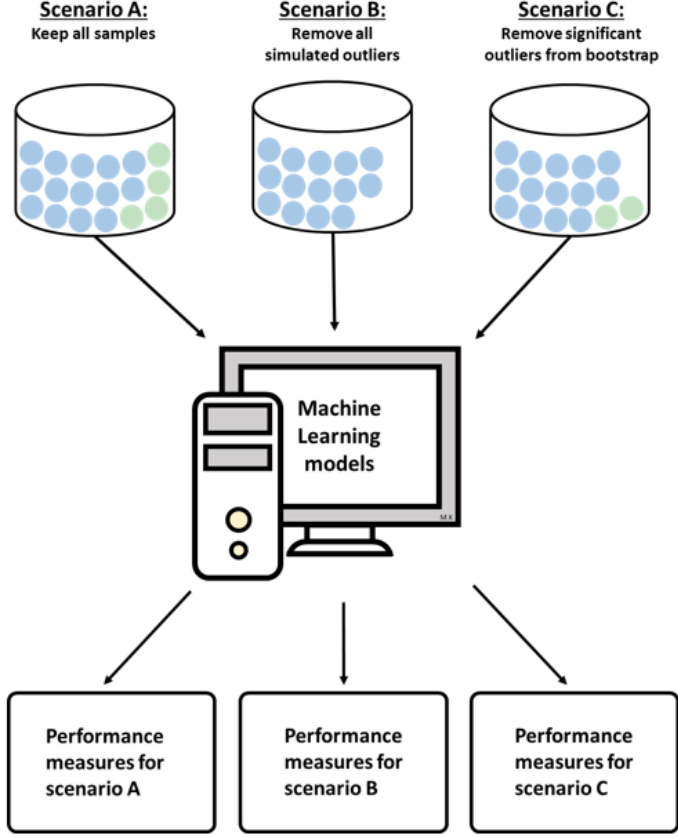
Figure 2. Second part of the analysis pipeline: evaluation of model performances for different outlier handling scenarios. After assessing outlier probabilities, three different scenarios were tested for the simulation data: ( A ) keep all samples, ( B ) remove all simulated outliers, ( C ) remove samples that were identified as significant outliers after bootstrapping. For all scenarios, three different ML models were trained and tested. Performance measures for different scenarios, ML models, and numbers of included genes were